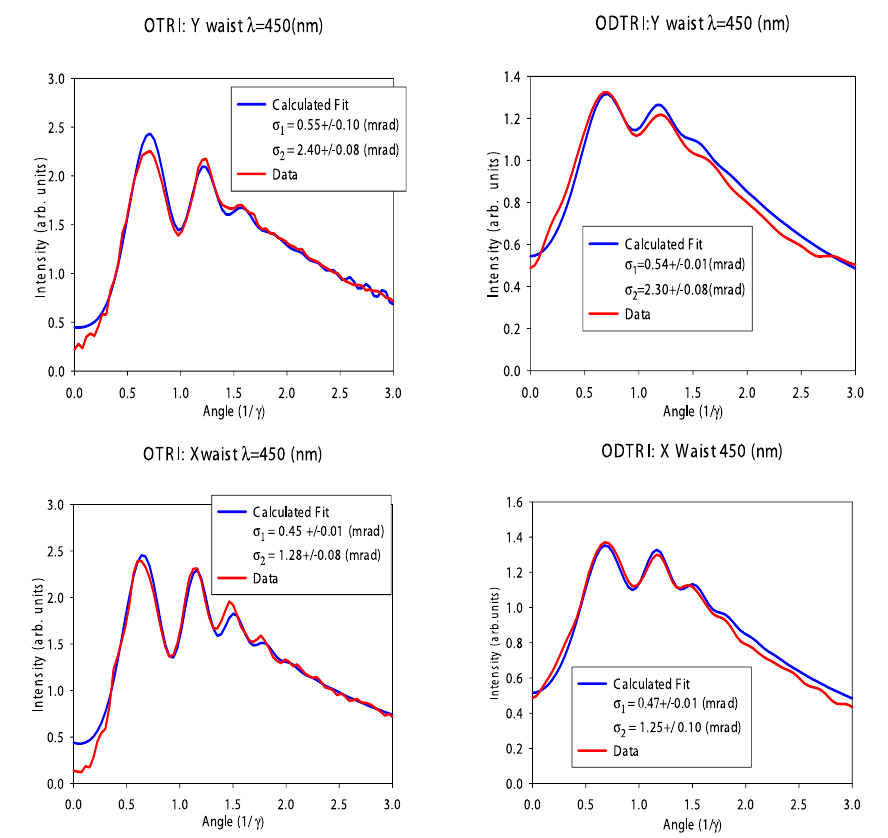
FIG. 8. (Color) OTRI and ODTRI fits and data taken with a 450 nm (cid:13) 10 nm bandpass filter at vertical ( Y ) and horizontal ( X ) beam waists.